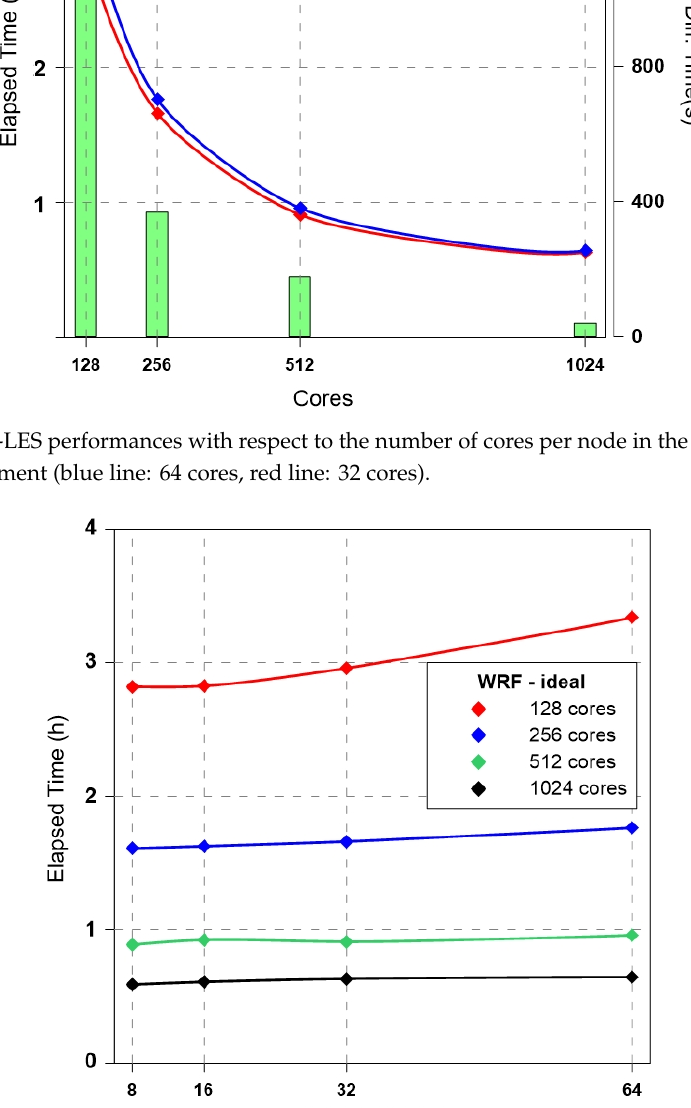
Figure 5. The simulation area of WRF-Northwestern Pacific Ocean (NWP); 2048 × 2048 resolution, dt = 5 s.